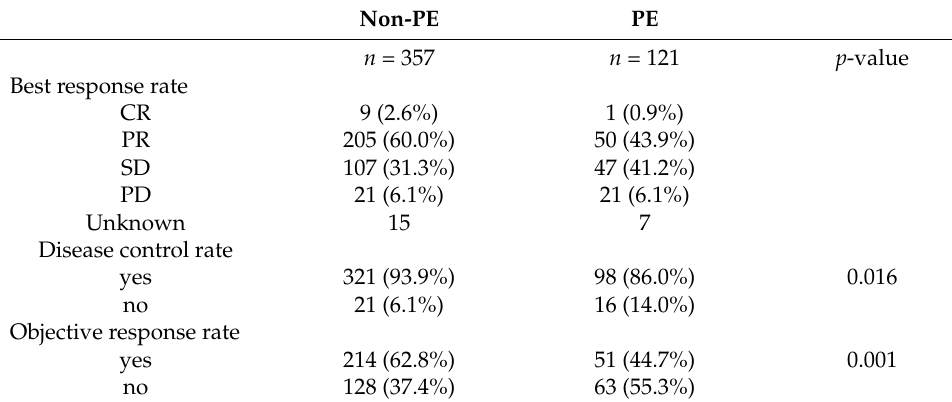
Table 2. Response outcomes in Non-PE and PE groups.